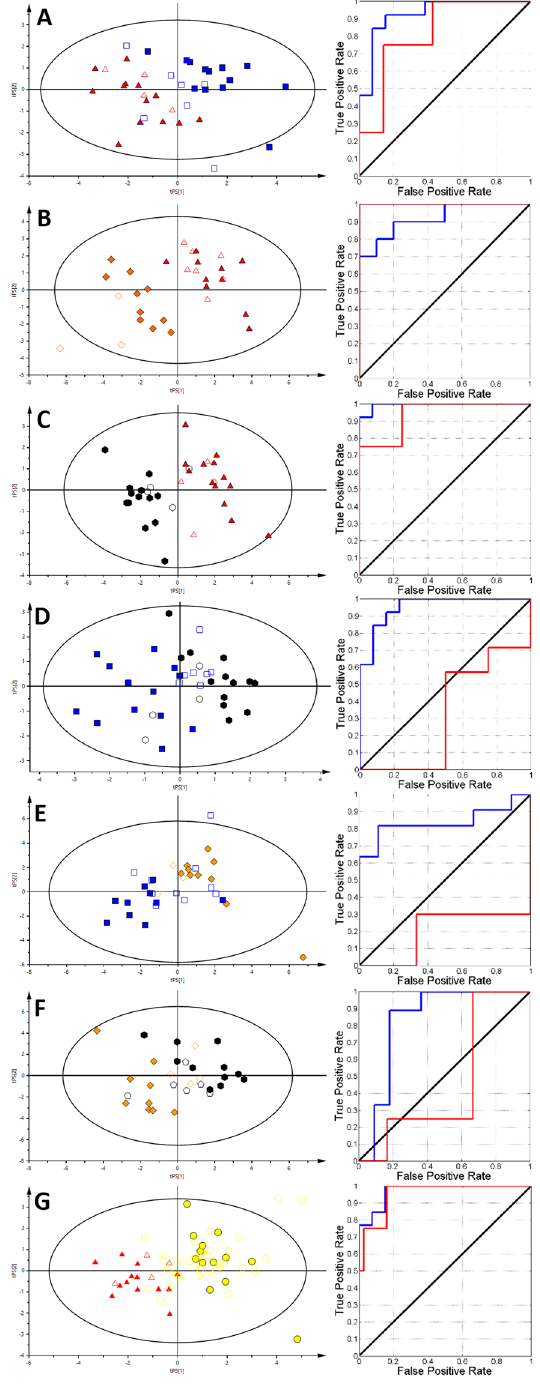
Figure 5. The VIP-PLS-DA models, ROC curves obtained from the fusion of data from urine and serum samples. ( A ) – NN vs HC; ( B) – FA vs HC; ( C) – TC vs HC; ( D) – TC vs NN; ( E) – FA vs NN; ( F) – FA vs TC; ( G) – P vs HC. Red triangles – healthy controls; blue boxes – non-neoplastic nodules; yellow diamonds – follicular adenoma; black hexagons – papillary thyroid cancer; gold circles – patients. Solid symbols: training set; empty symbols: predicted test set. Small violet circles – metabolites that influence group differentiations in PLS-DA